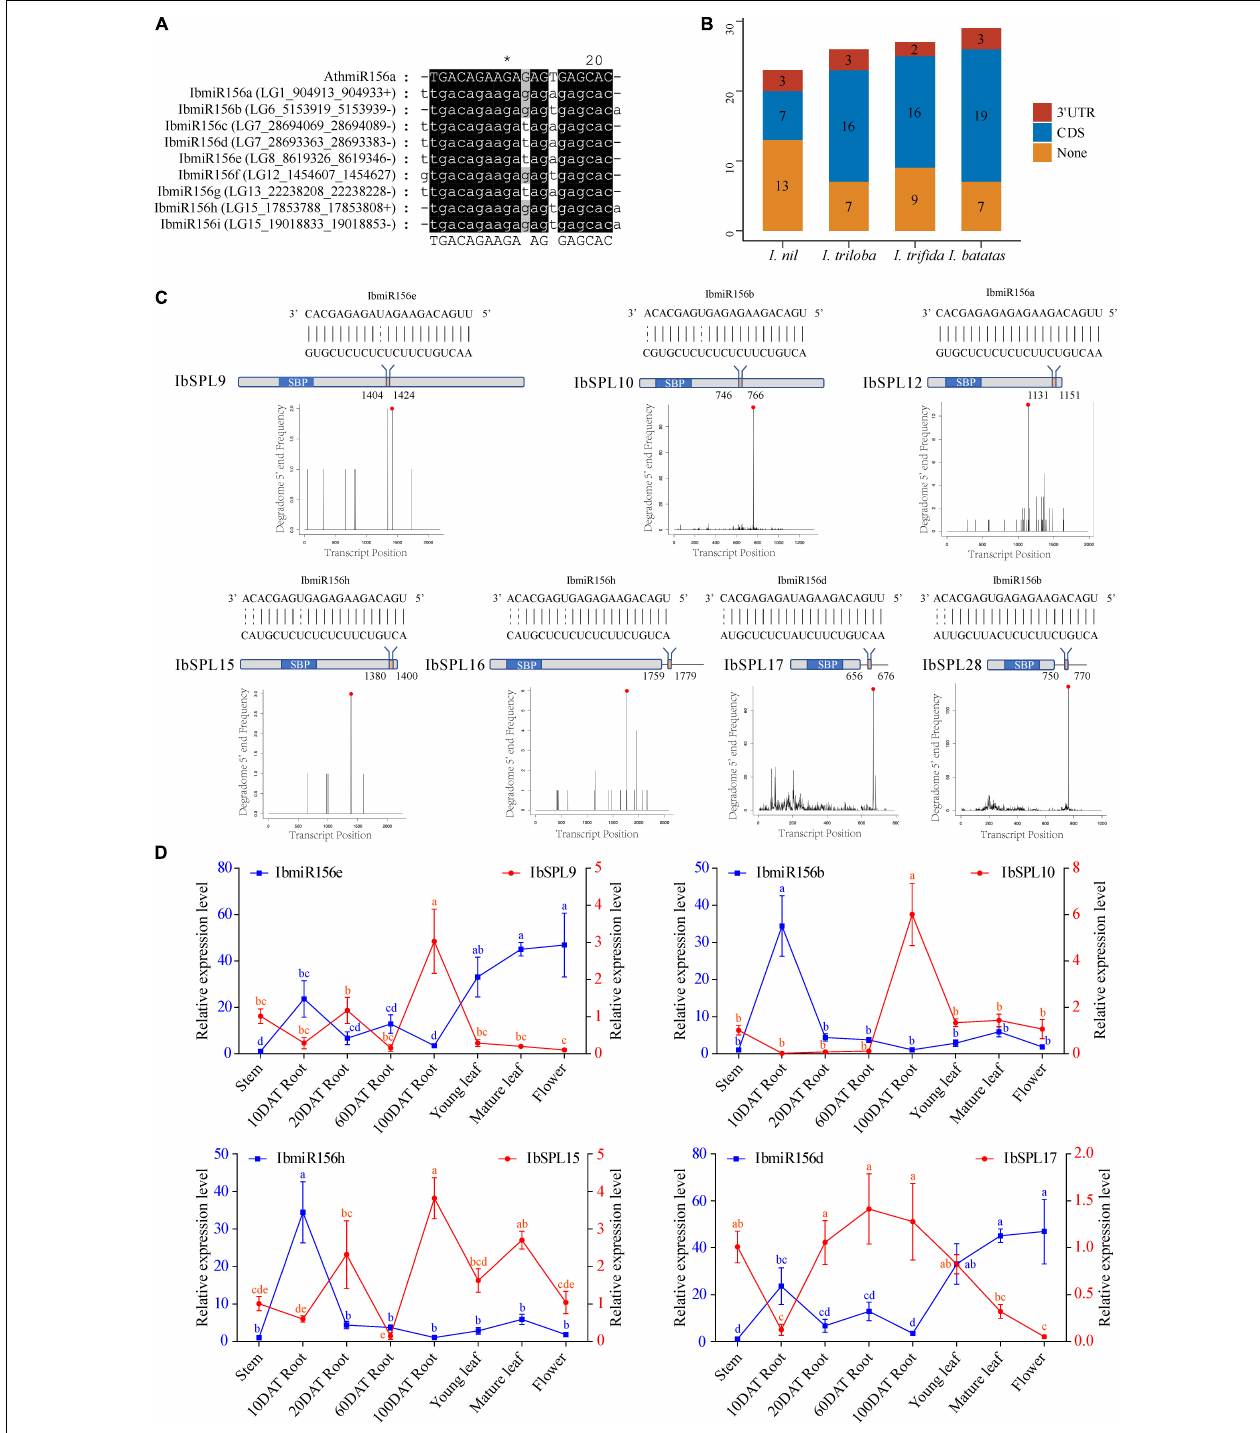
FIGURE 4 | miR156 target site of the Ipomoea SPL genes. (A) Multiple alignments of identified IbmiR156 sequences. (B) The summary of miR156-targeted SPL genes in the Ipomoea genus. (C) Schematic diagram of IbSPL genes targeted by IbmiR156 . The top diagram represents the complementary sequences between IbmiR156 and their targets. The gray box indicates the CDS region, the blue box represents the SBP domain, and the red box indicates the IbmiR156 target site. The diagram below is the target plots (t-plots) of IbmiR156 targets confirmed by degradome sequencing. (D) Expression correlation between IbmiR156 and IbSPLs . The lines represent the abundance of IbmiR156 and IbSPLs in different tissues. The Y-axis on the left and right indicates the relative expression levels of the IbmiR156 and IbSPLs , respectively. Relative expression was calculated using the 2 − (cid:49)(cid:49) CT method. The error bars indicate the standard deviations of the three biological replicates. Different letters indicate statistically significant differences at p <